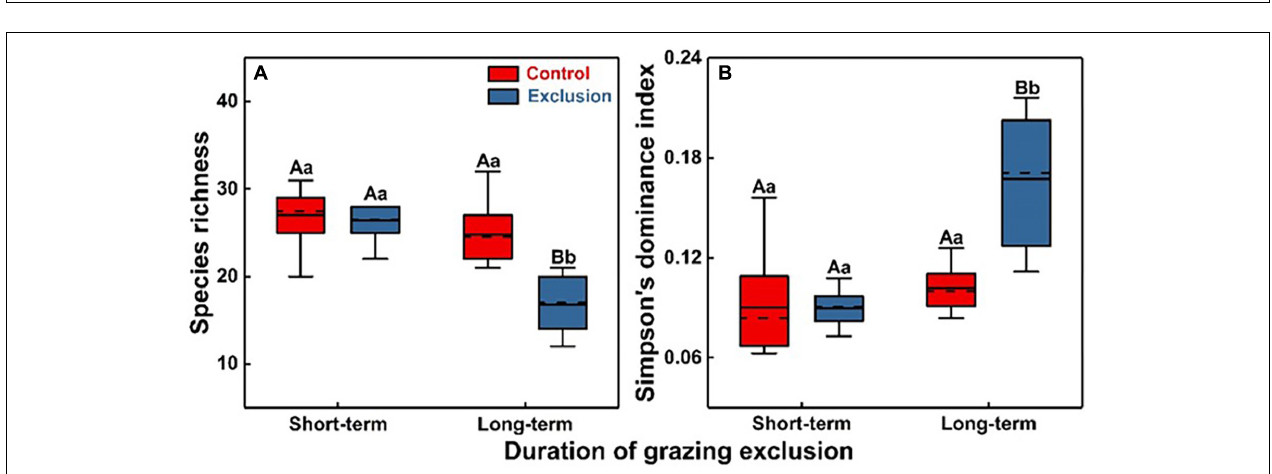
FIGURE 2 | Plant species diversity (A) and Simpson’s dominance index (B) under short-term and long-term grazing exclusion and in control stands. Uppercase and lowercase letters indicate the differences between control (Grazing) and crazing exclusion and differences under different durations of grazing exclusion, respectively.